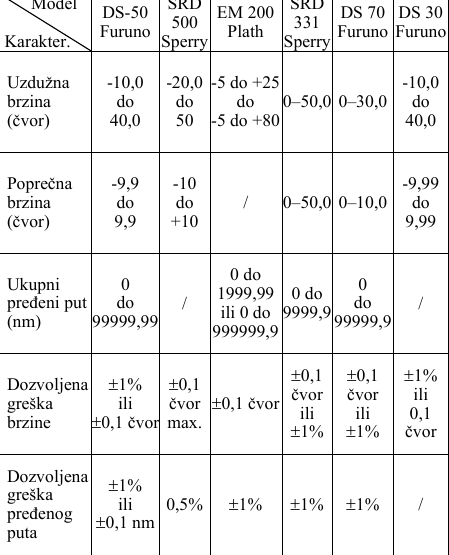
U tabeli 1 prikazane su karakteristi- skladu sa standardom IEC 1023 [ 6 ] . Model